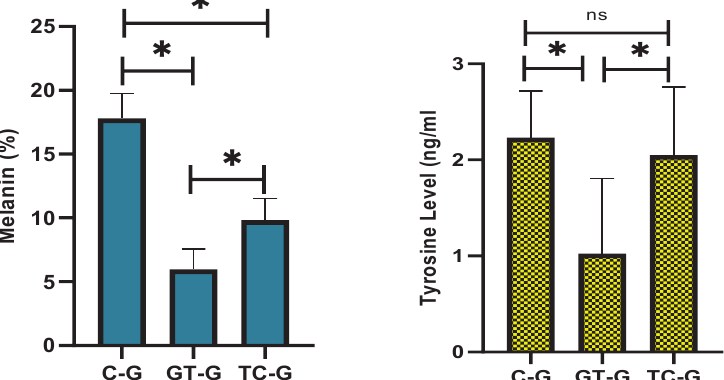
Figure 2. Post Hoc statistical analyis on Melanin and Tyrosinase between group. * p<0.05; ns: not Figure 2 . Post Hoc statistical analyis on Melanin and Tyrosinase between group. * p<0.05; ns: not significant Figure 2 . Post Hoc statistical analyis on Melanin and Tyrosinase between group. * p<0.05; ns: not significant Figure 2 . Post Hoc statistical analyis on Melanin and Tyrosinase between group. * p<0.05; ns: not significant